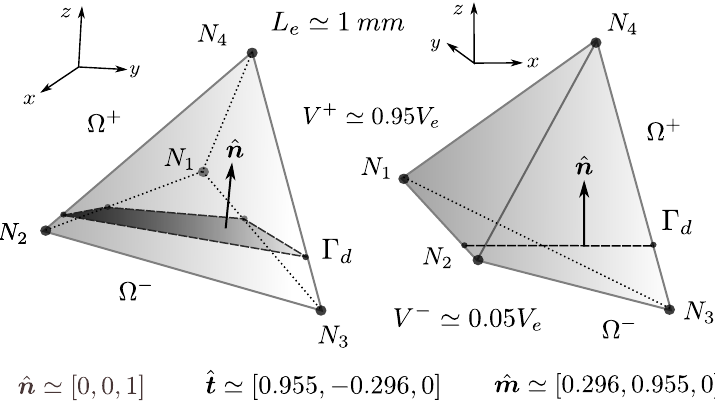
Figure 13. Two different views of a realistic element taken as the reference for the numerical simula- tions to test all formulations described in this